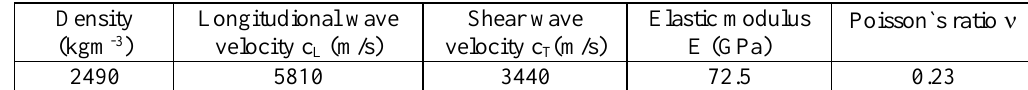
Table 1 . Properties of tested glass.